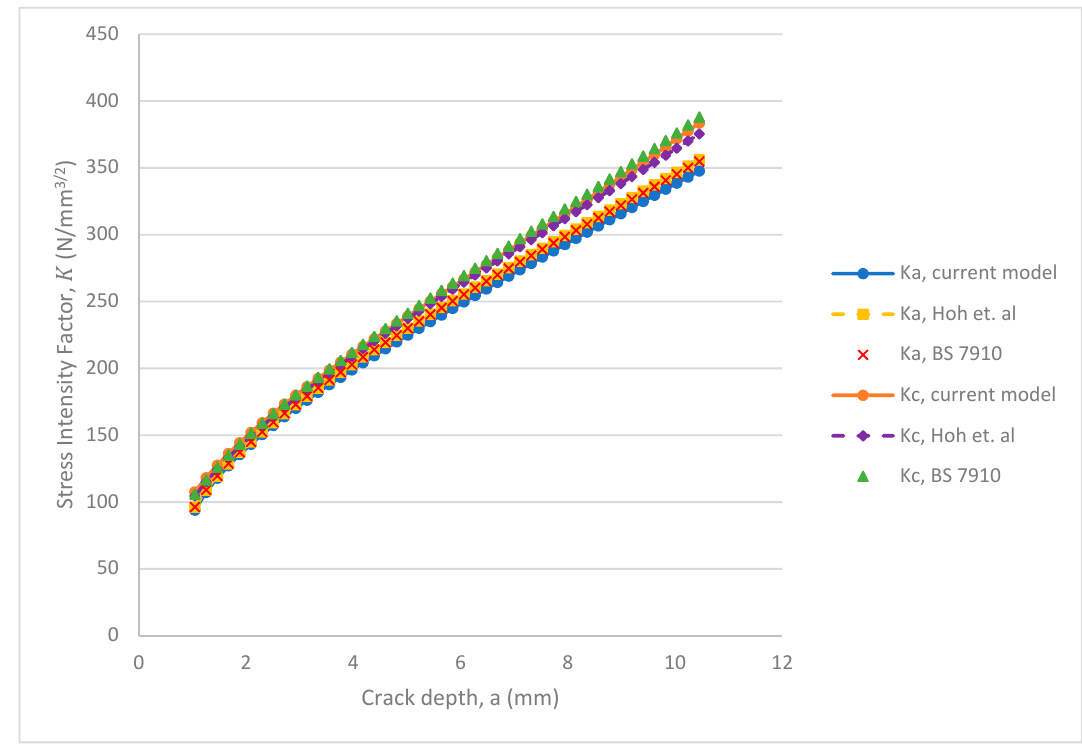
Figure 21. SIFs at the deepest point ( K a ) and surface point ( K c ) for an external semi-elliptical crack in a pipe under cyclic tension (initial a/c = 1.0).